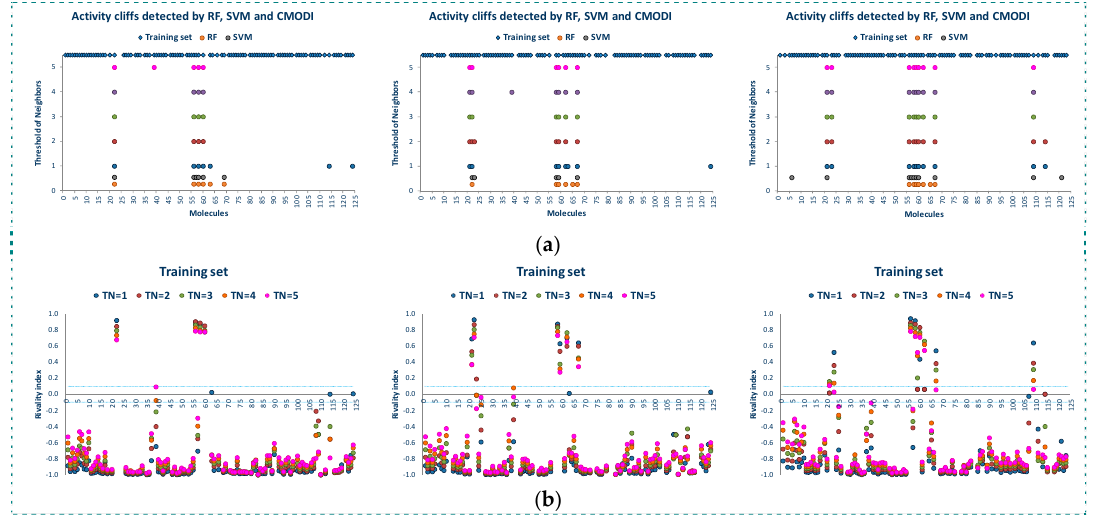
Figure 5. Outliers detected by the algorithms and activity cliffs detected by the rivality index for different values of TN for the three training sets (TRS) ( a ), values of the rivality index for the molecules included in the three training sets ( b ).